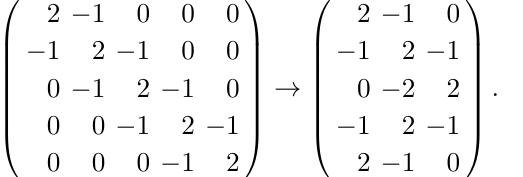
→ α . For example in the case of A k k